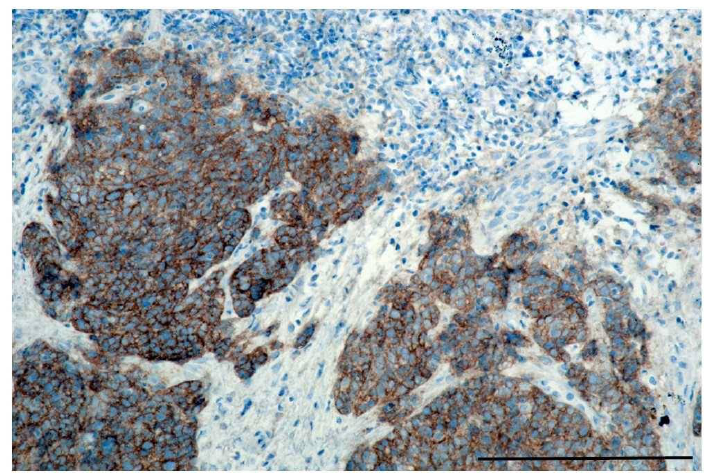
Figure 2. Epidermal growth factor receptor (EGFR) expression in a high-risk HPV (hr-HPV)-positive oropharyngeal squamous cell carcinoma (OPSCC) specimen. EGFR, epidermal growth factor receptor; hr, high risk; HPV, human papilloma virus, bar is 1 µm.